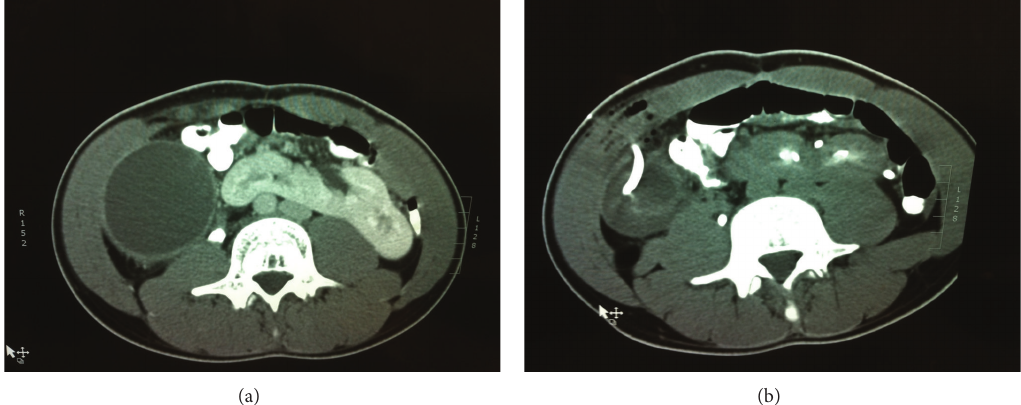
Figure 1: (a) Thickened wall cyst and horseshoe kidney. (b) Drainage of the